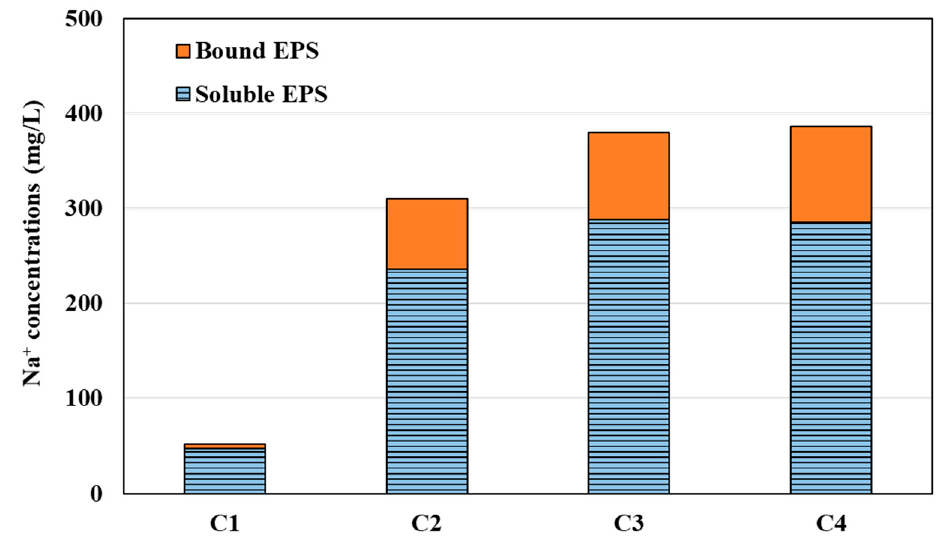
Figure 6. Na + concentration in bound EPS and soluble EPS at C1 (no salt and no cation), C2 (5 g NaCl/L and no cation), C3 (5 g NaCl/L and 200 mg/L Ca 2+ ), and C4 (5 g NaCl/L and 70 mg/L Mg 2+ ).